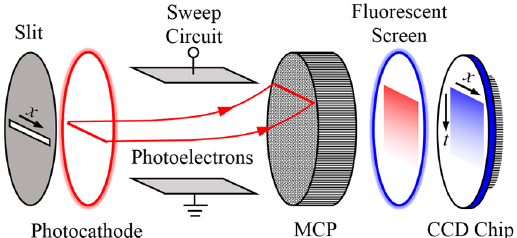
Fig. 7. Principle of FLIM with a streak camera. Photons with di®erent arrival times are de°ected to di®erent positions along the direction perpendicular to the